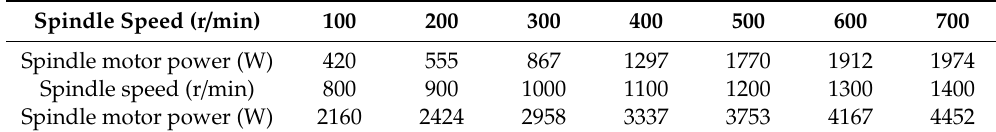
Figure 4. Main parameters of machined gear and hob tool. Table 1. Relevant parameters of the motorized spindle system. Table 2. Power input of spindle motor under di ff erent spindle speeds.